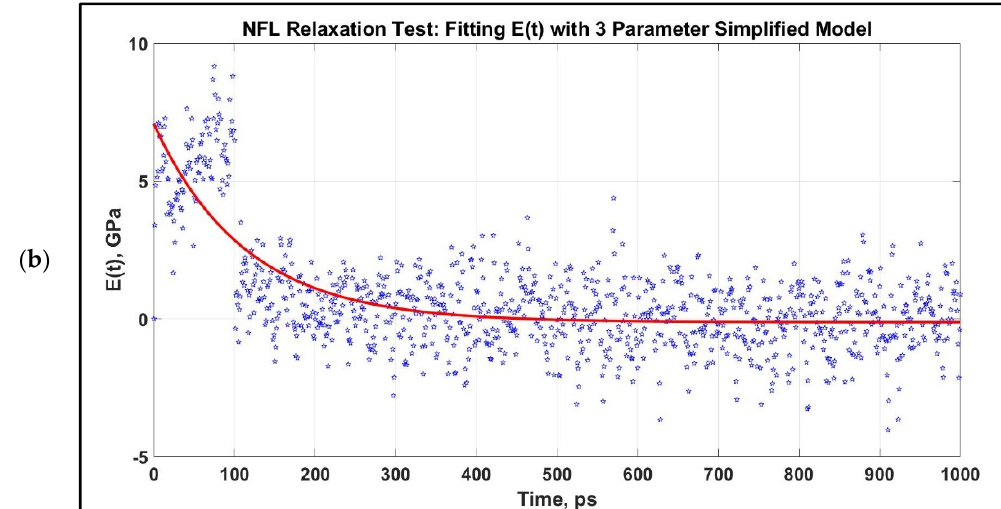
Figure 5. Modulus, E(t) vs. time for 1 ns relaxation test for NFL, which are stretched to 80% at two strain rates. The relaxation curves at two strain rates are not significantly distinct for NFL. After obtaining the E(t) vs. time graph, they are fitted to a three-parameter simplified model for an initial stretch of 0.8 at two different strain rates. ( a ): 1 × 10 8 s − 1 , ( b ): 1 × 10 9 s − 1 . Table 1. Simplified Model Parameters from NFL Relaxation Test. Table 2. Relaxation Shear Modulus and Bulk Modulus Parameters for the Simplified Model of NFL.